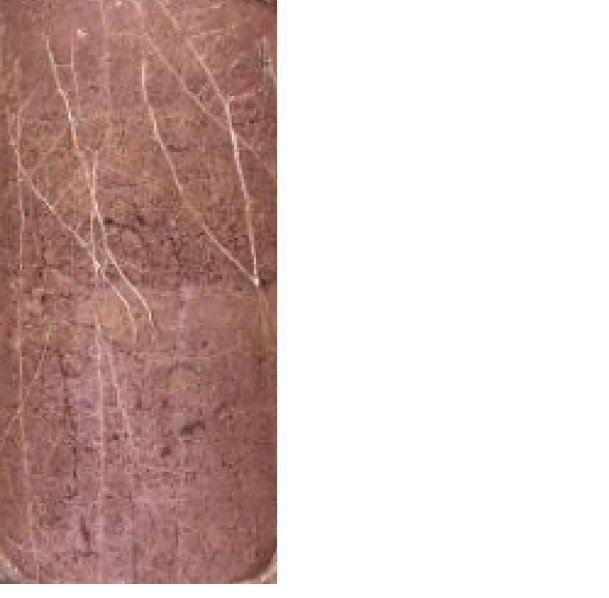
Figure 7. Side root system.